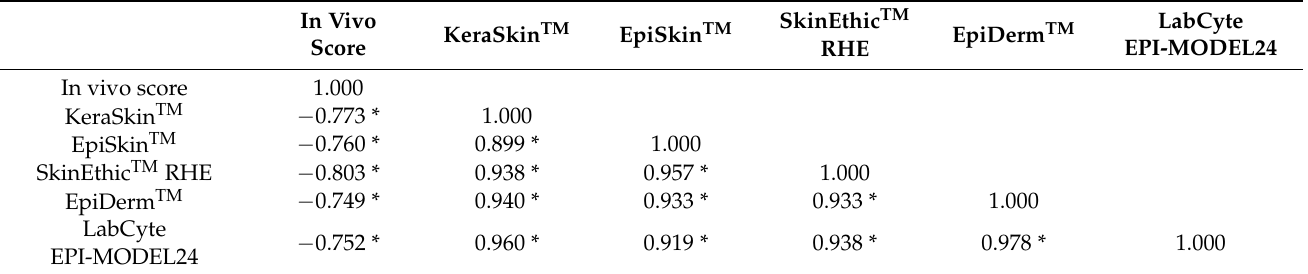
Table 4. Correlation between in vivo score and VRM